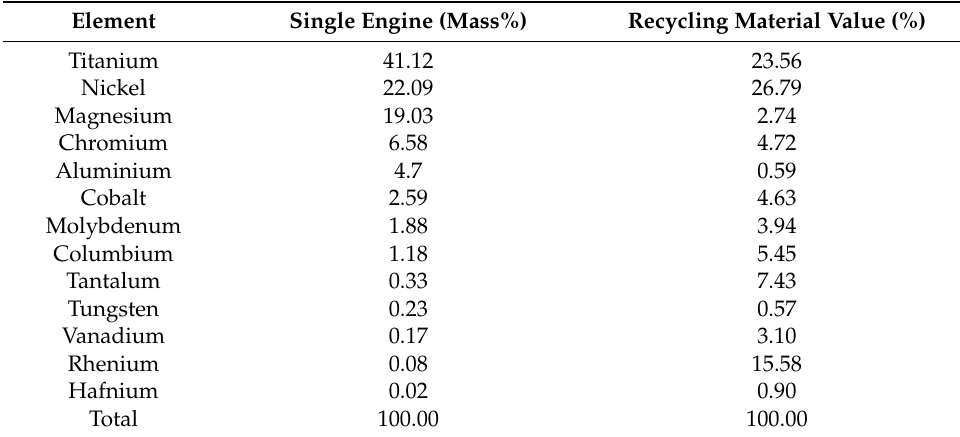
Table 2. Elements in A/C engines (based on [8]).